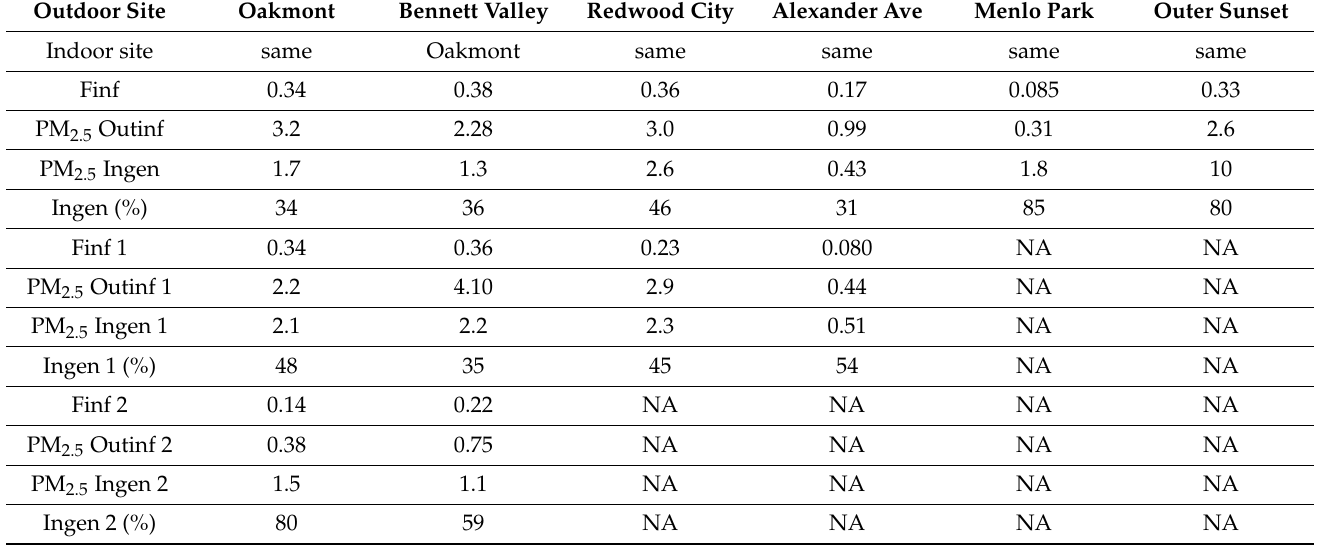
Table 7. Infiltration factors (F inf ) and mean PM 2.5 for outdoor-infiltrated (Out inf ) and indoor- generated (In gen ) particles, including the percent contribution to total indoor PM 2.5 from the indoor- generated particles (In gen (%)). These variables are shown for the entire datasets and for the subsets (1 and 2) created when the Forbidden Zone was violated by too many